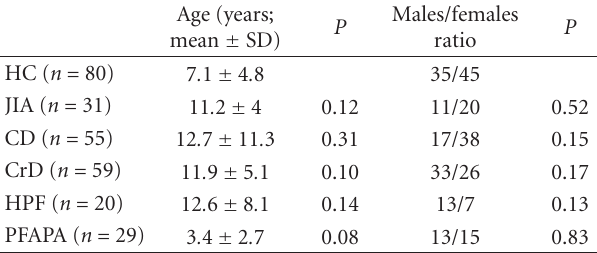
Table 1: Patients and controls demographic data. Mean age and males/female ratio were reported for healthy controls (HC) and in patients with juvenile idiopathic arthritis (JIA), celiac disease (CD), Crohn’s disease (ChD), hereditary periodic fevers (HPFs), and PFAPA syndrome (PFAPA). Age and males/females ratio from patients were compared with HC using an independent t -test and a Fisher exact test,